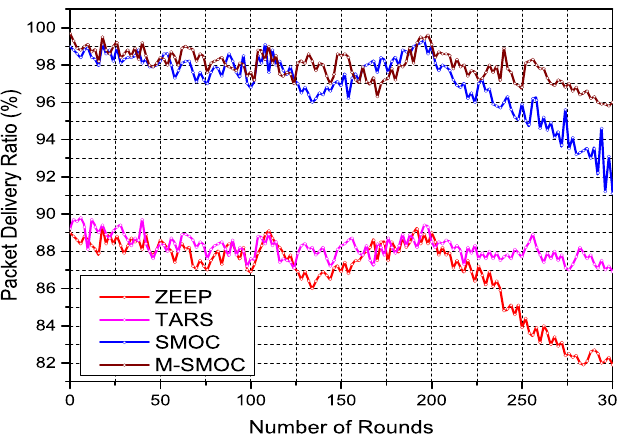
Figure 11. Performance comparison of the packet delivery ratio.